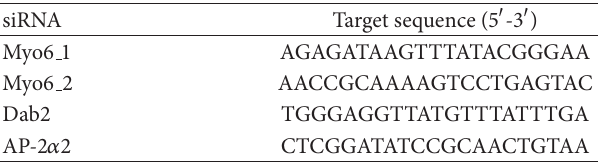
Table 2: Sequences used in siRNA experiments.